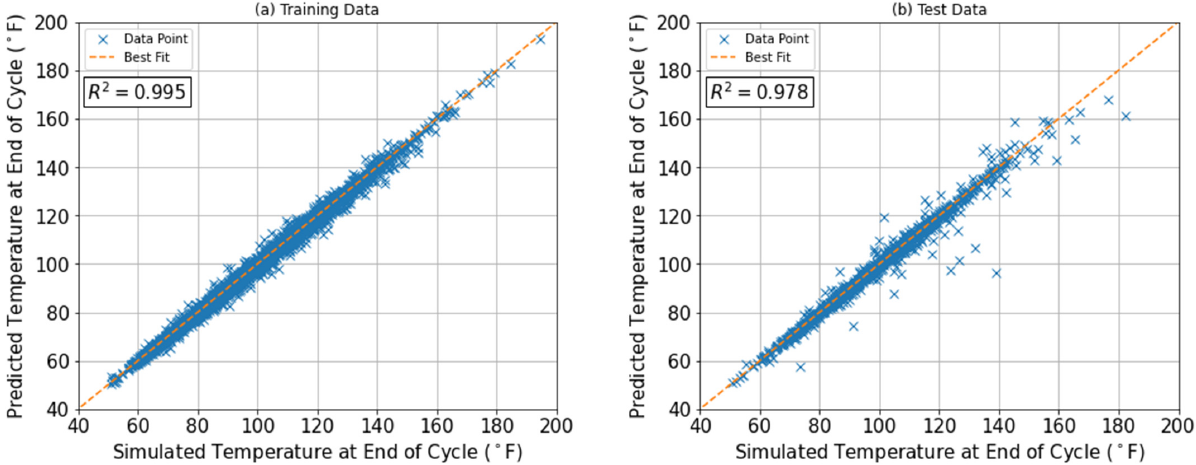
Figure 14. Predicted and simulated plot of ( a ) training data and ( b ) testing data for reservoir temperature at the end of the cycle—neural network model.